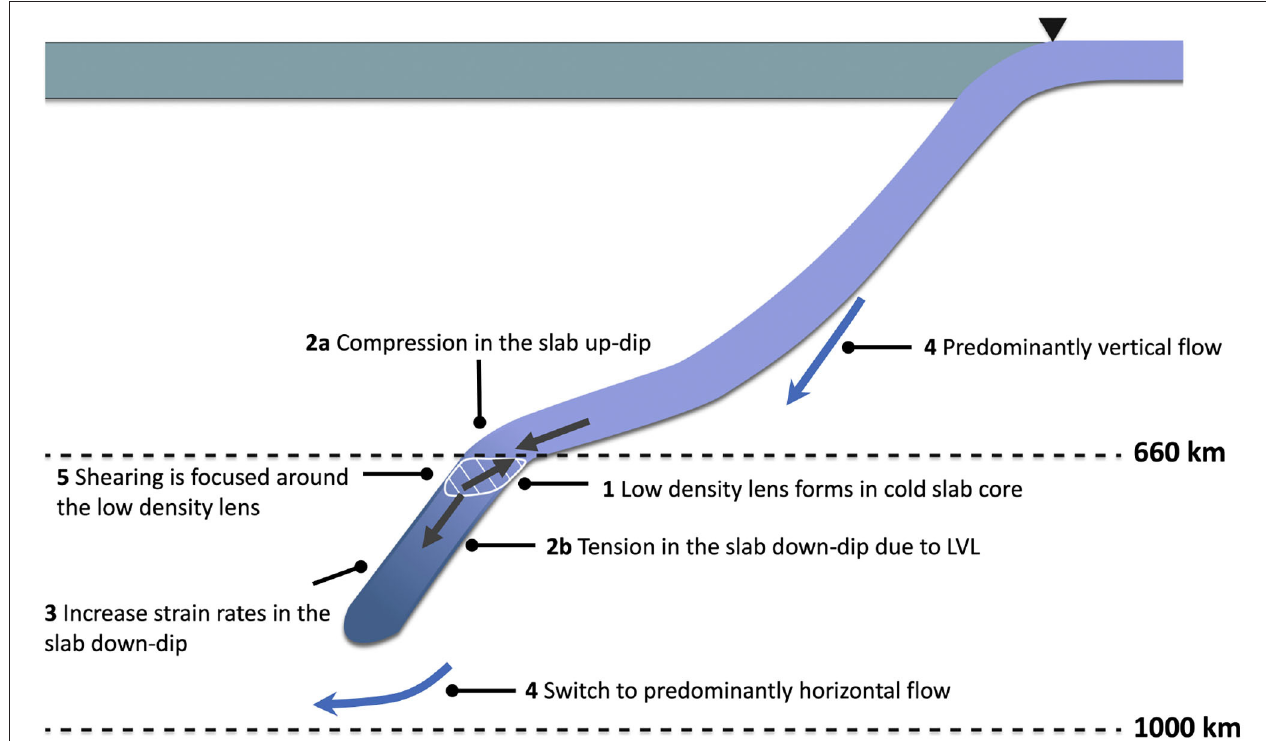
FIGURE 1 | Schematic showing the slab orphaning process. A lens of anomalously buoyant material forms within the cold slab core due to the temperature dependence of the phase boundary depth of the phase change (1). The anomalously buoyant material resists subduction and compresses the slab up-dip (2a). Faster sinking speeds in the LVL result in a proto-orphan in tension (2b) and give rise to an opposing force balance up and down-dip of the phase change. Faster slab sinking speeds in the LVL increase the strain rates in the proto-orphan and reduce its viscosity resulting in weakening (3). An increase in viscosity at 1,000 km mainly confines the induced slab-mantle viscous flow to the mantle above 1,000 km depth, forcing a switch in predominantly vertical flow above 660 km depth to predominantly horizontal flow in the LVL (4). Horizontal flow in the LVL increases the shearing and stretching of the slab around the low density lens (5) until the slab splits into separate flattened parent slab and a quasi-vertical orphan slab. The flattened parent slab travels laterally on top of the lower mantle sustaining subduction at the trench as the orphan slowly sinks toward the